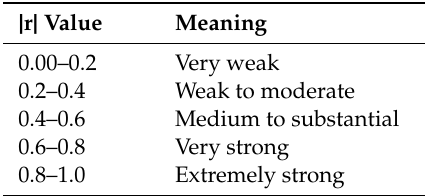
Table 8. Statistical analysis methods on the selected datasets.